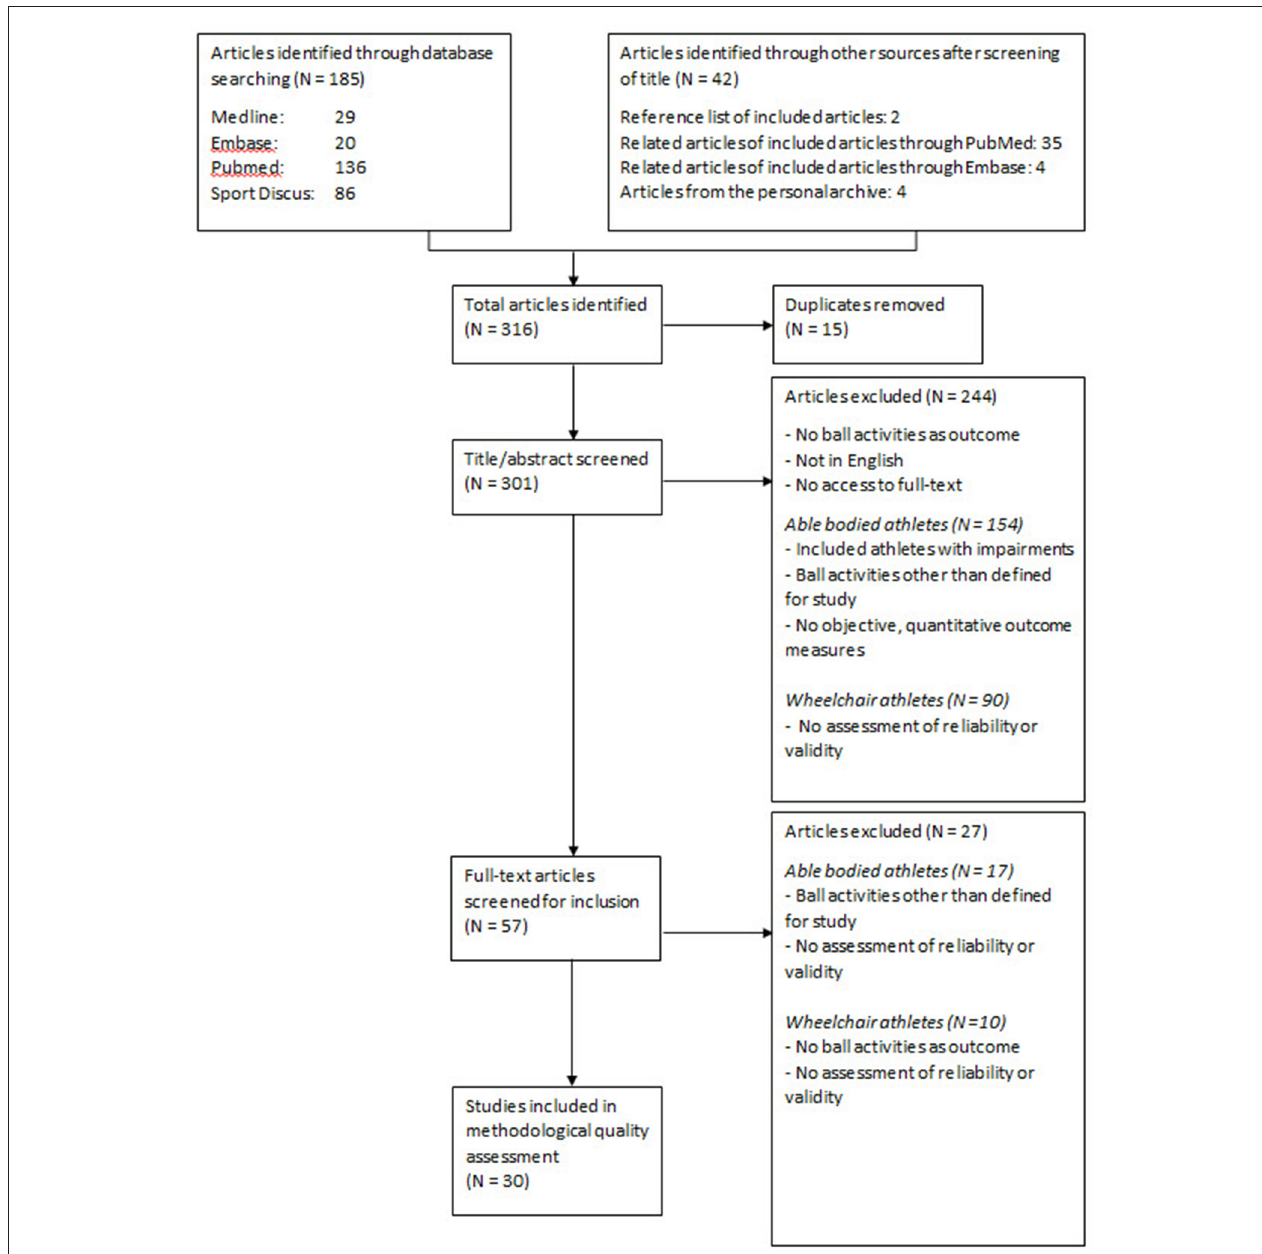
FIGURE 1 | Flowchart of the literature